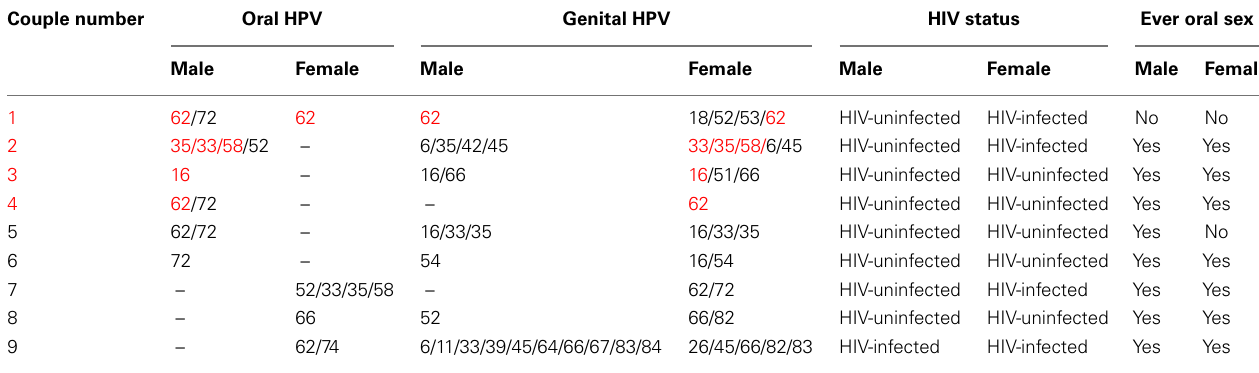
Table 3 | Oral-genital concordance couple characteristics among nine couples with at least one oral HPV infection